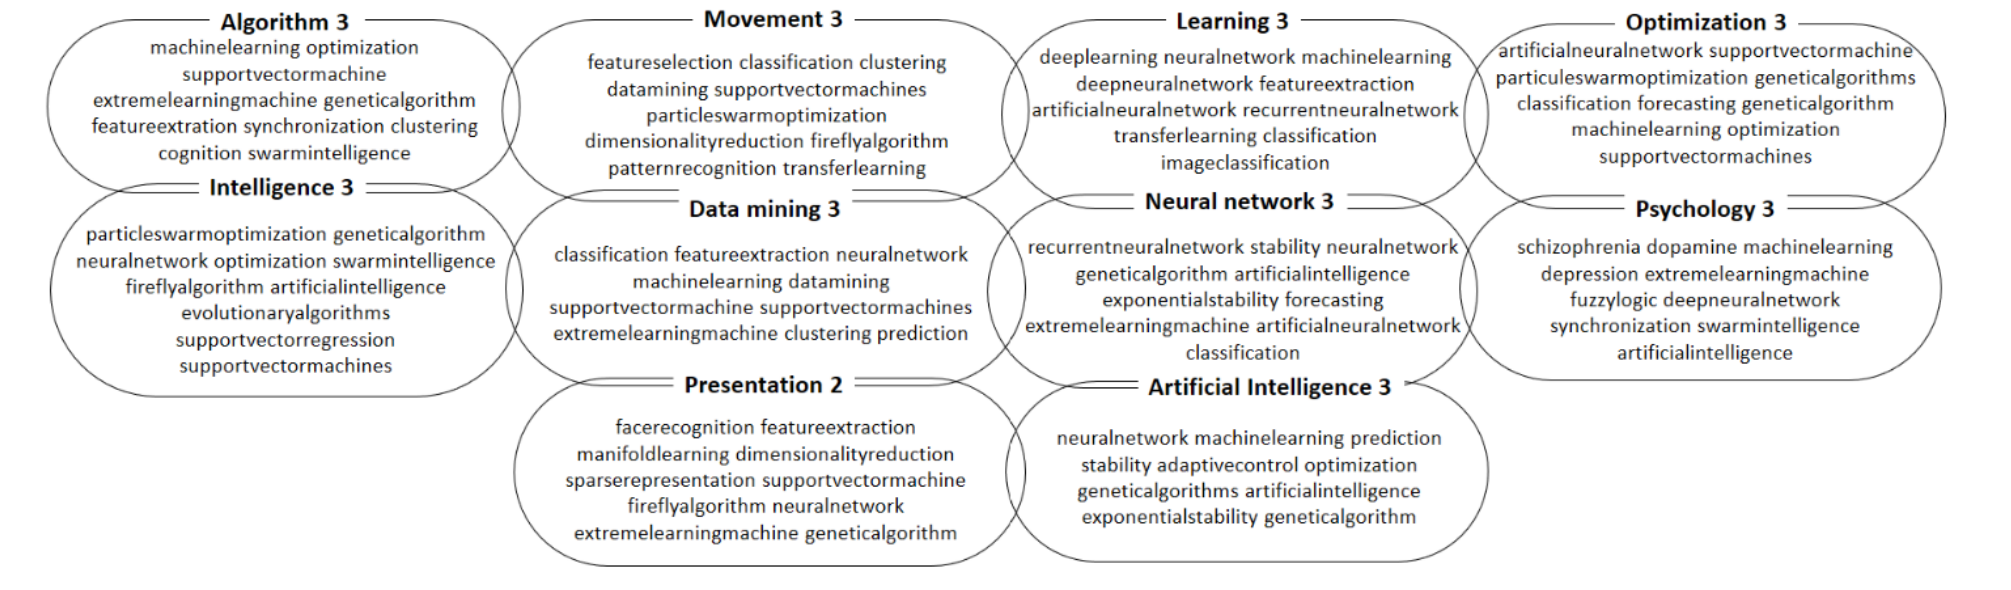
Figure 8. The ten clusters for the period from 2016 to